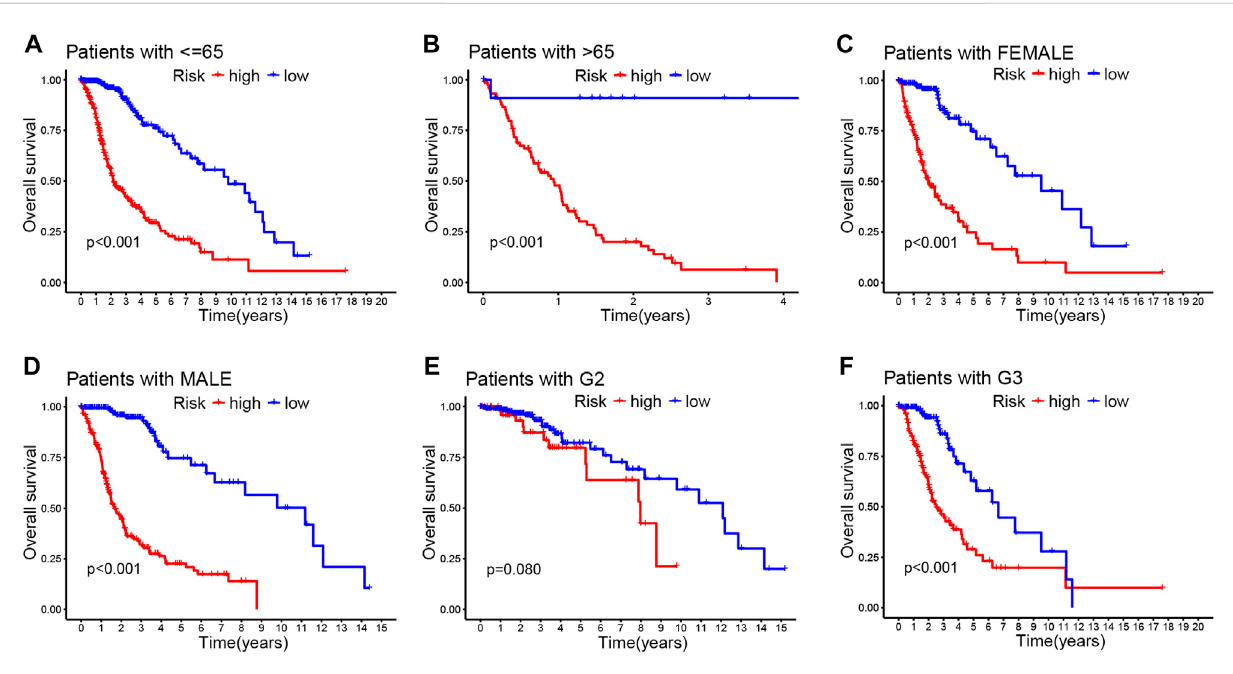
FIGURE 3 CorrelationbetweentheprognosticCRLssignatureandclinicopathologicalcharacteristics (A – F) .Kaplan – Meiercurveforoverallsurvivalindifferent clinical features such as age (A,B) , gender (C,D) , and tumor grade (E,F)